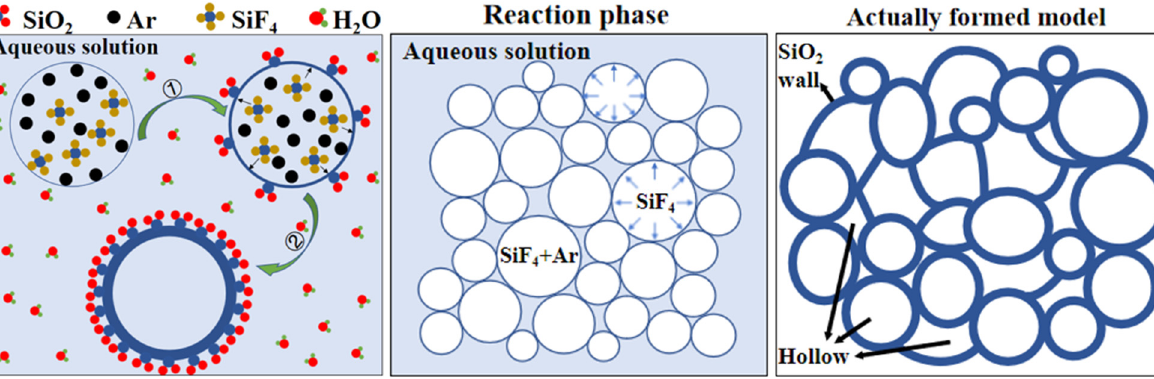
Figure 5. Growth mechanism of cellular silica in aqueous solution.